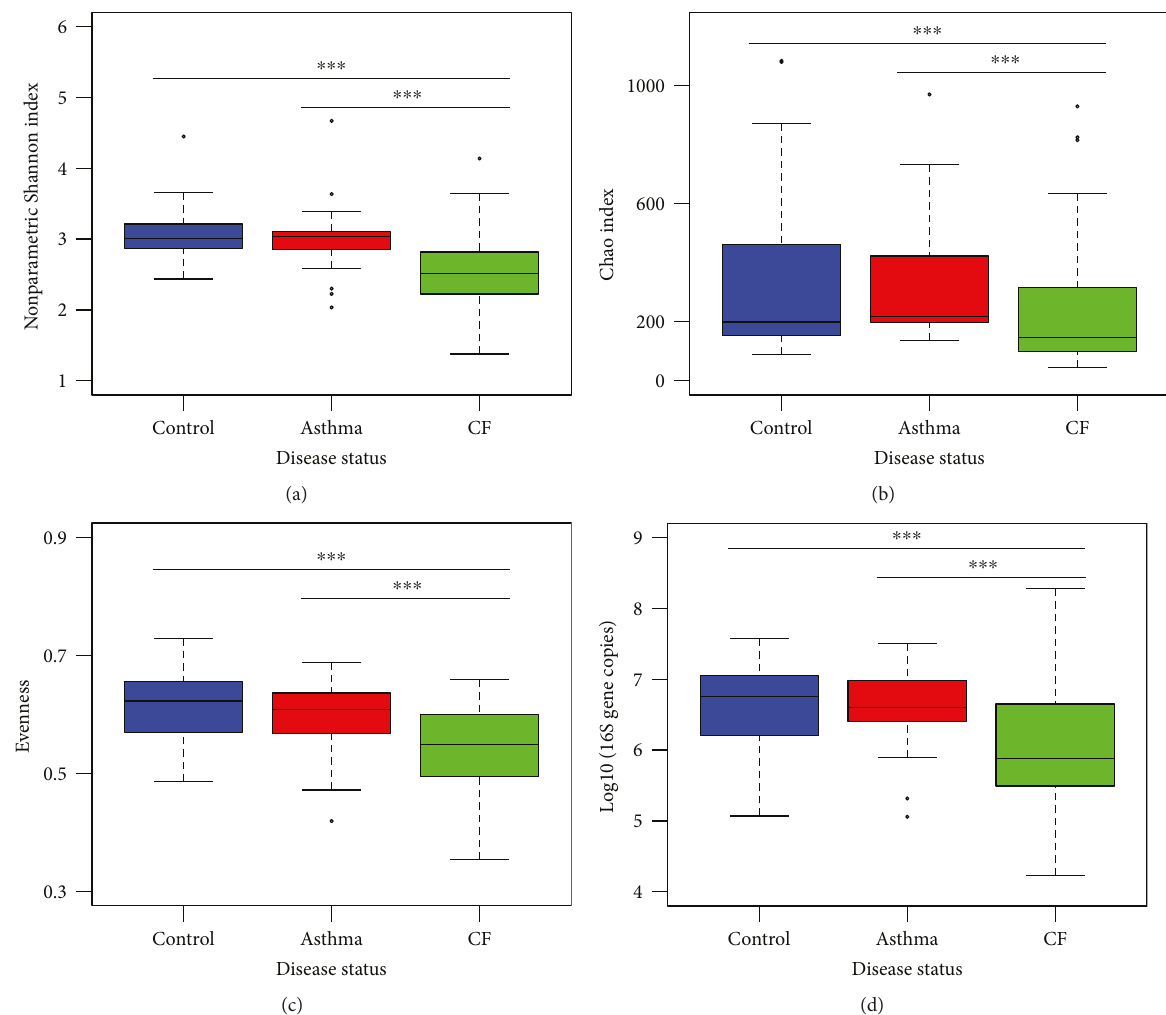
Figure 2: Diversity and biomass are decreased in the oropharyngeal microbiome of children with CF. (a) α -Diversity was assessed by the nonparametric Shannon index. (b) Richness was estimated by the Chao index. (c) Evenness was derived from a Shannon index-based measure of evenness. (d) Global biomass measured as the number of 16S rRNA gene copies. Statistical signi fi cance was calculated by the Wilcoxon test. ∗∗∗ p value <